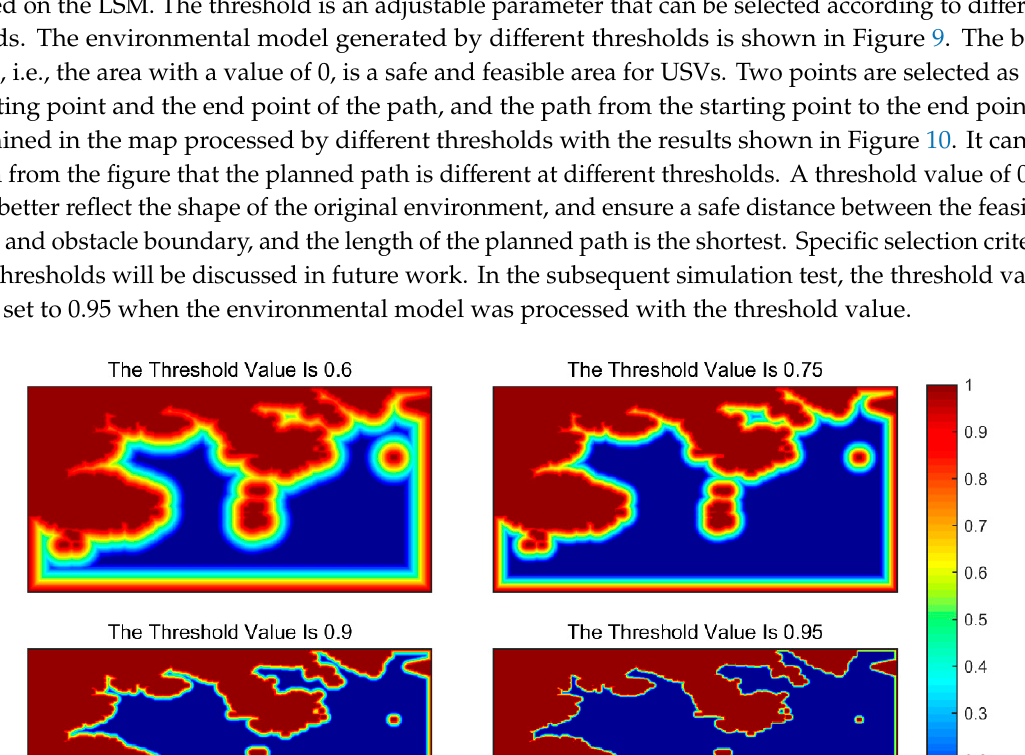
Figure 9. Environment model after different threshold processing.